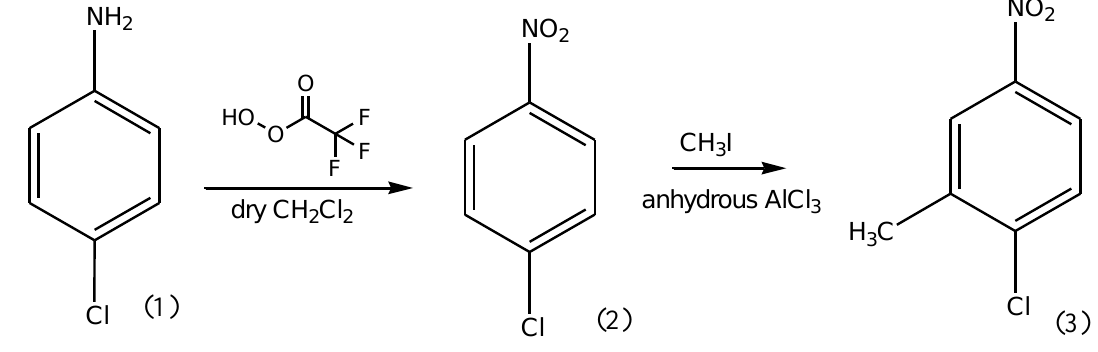
Figure 1. Synthesis of 1-chloro-2-methyl-4-nitrobenzene